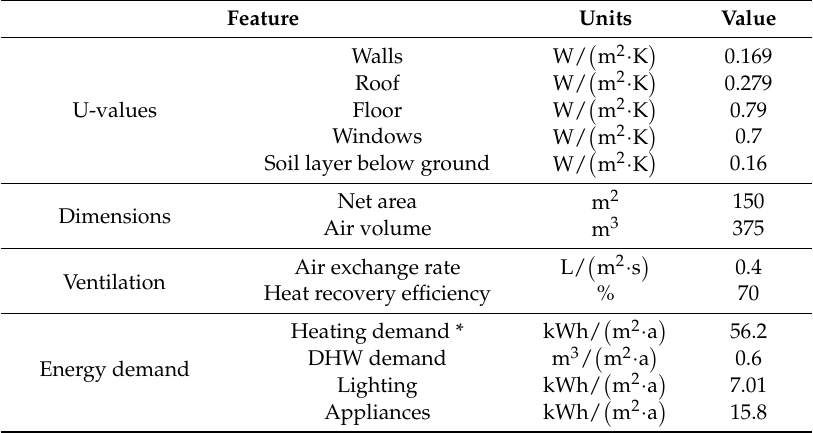
Table 1. The main features of the simulated